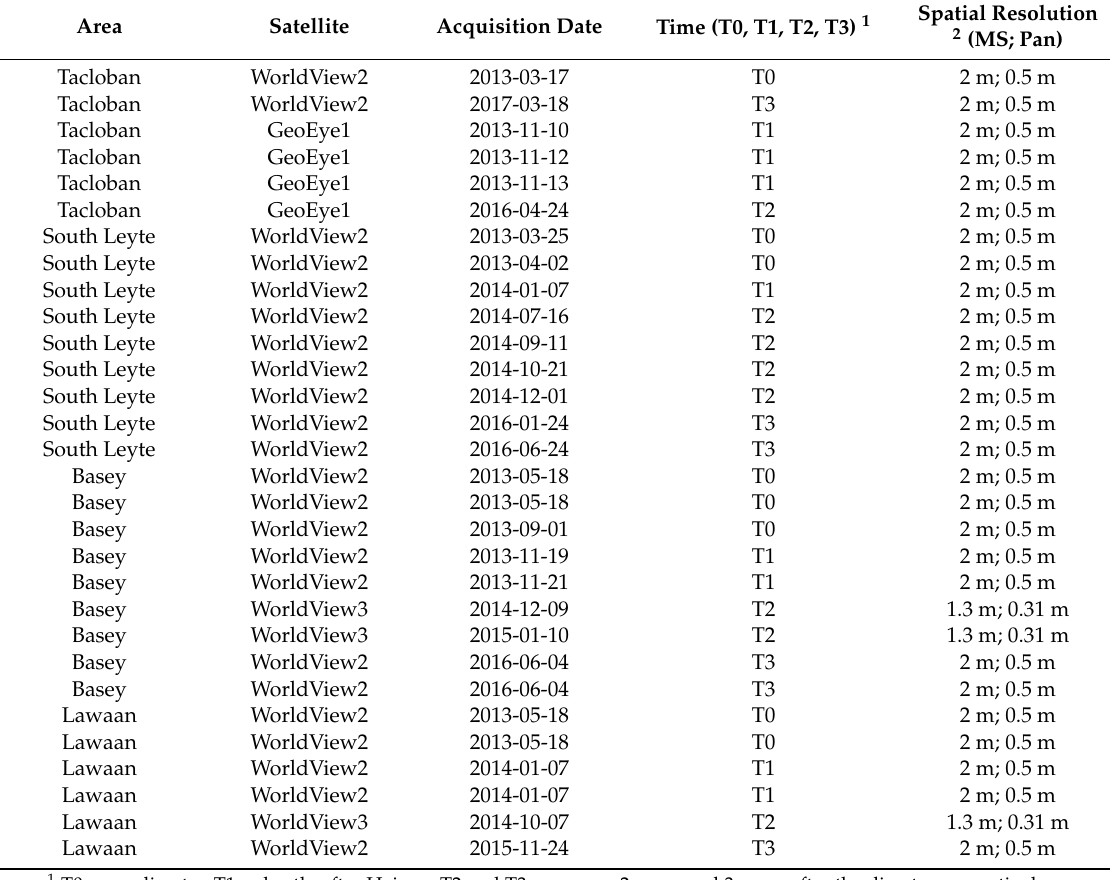
Table 1. Satellite images used in this